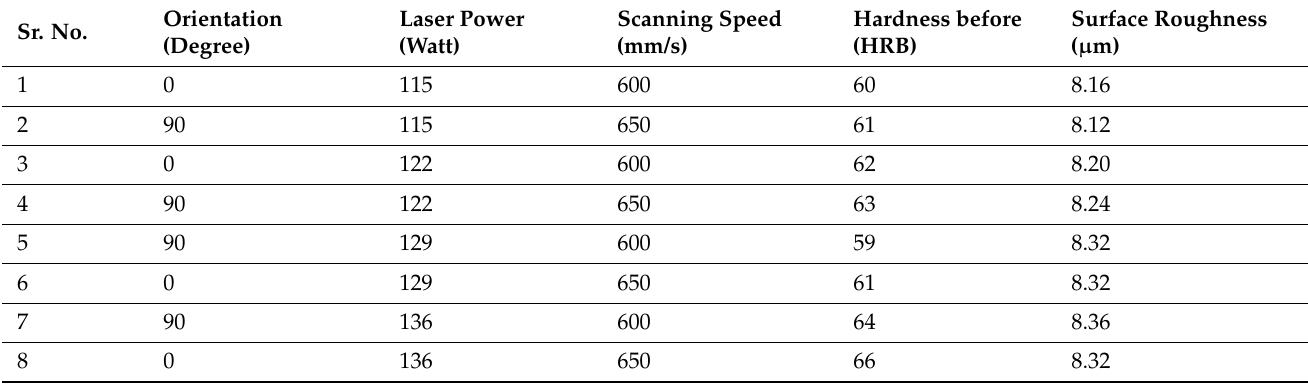
Table 2. L 8 Orthogonal